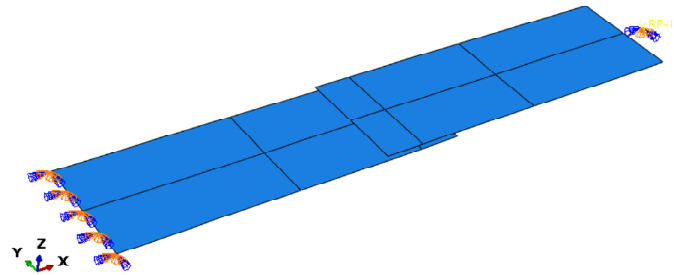
Figure 7. Boundary conditions of the simplified analysis model.